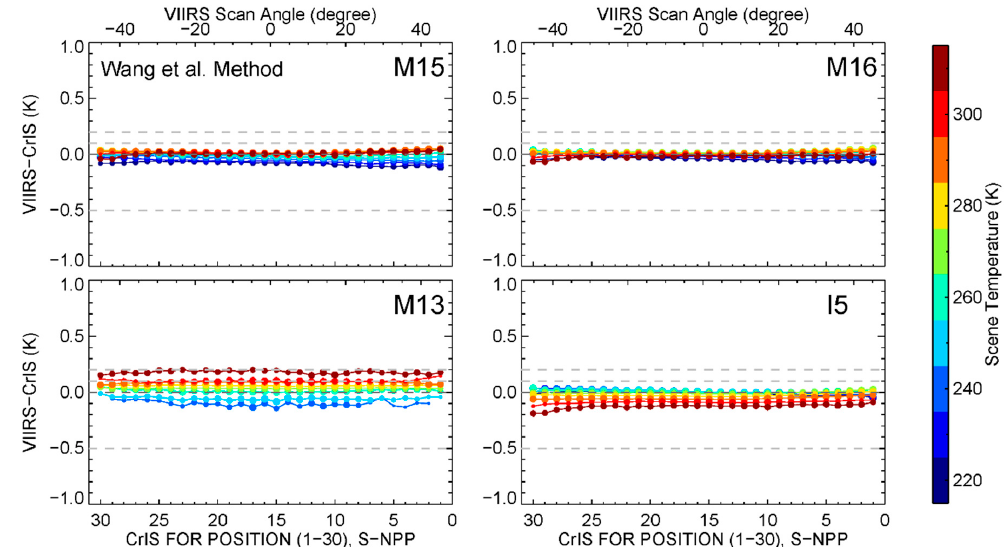
Figure 12. S-NPP VIIRS–CrIS BT differences at 10 scene temperatures and as function of CrIS FOR position and VIIRS scan angle. VIIRS M15–M16, M13, and I5 SDRs from March 18, 2019 were reprocessed using the Wang et al. method derived on-orbit RVS. Under each scene temperature, the sizes of the filled circles are proportional to the number of data samples used. Table 6. S-NPP VIIRS–CrIS scan averaged biases at 10 scene temperatures for the NOAA operational (prelaunch RVS) and reprocessed (the Wang et al. method derived on-orbit RVS) SDRs. Unit for scene temperatures and biases: K. Prelaunch RVS Wang et al. On-Orbit RVS Scene Temperature M15 M16 M13 I5 M15